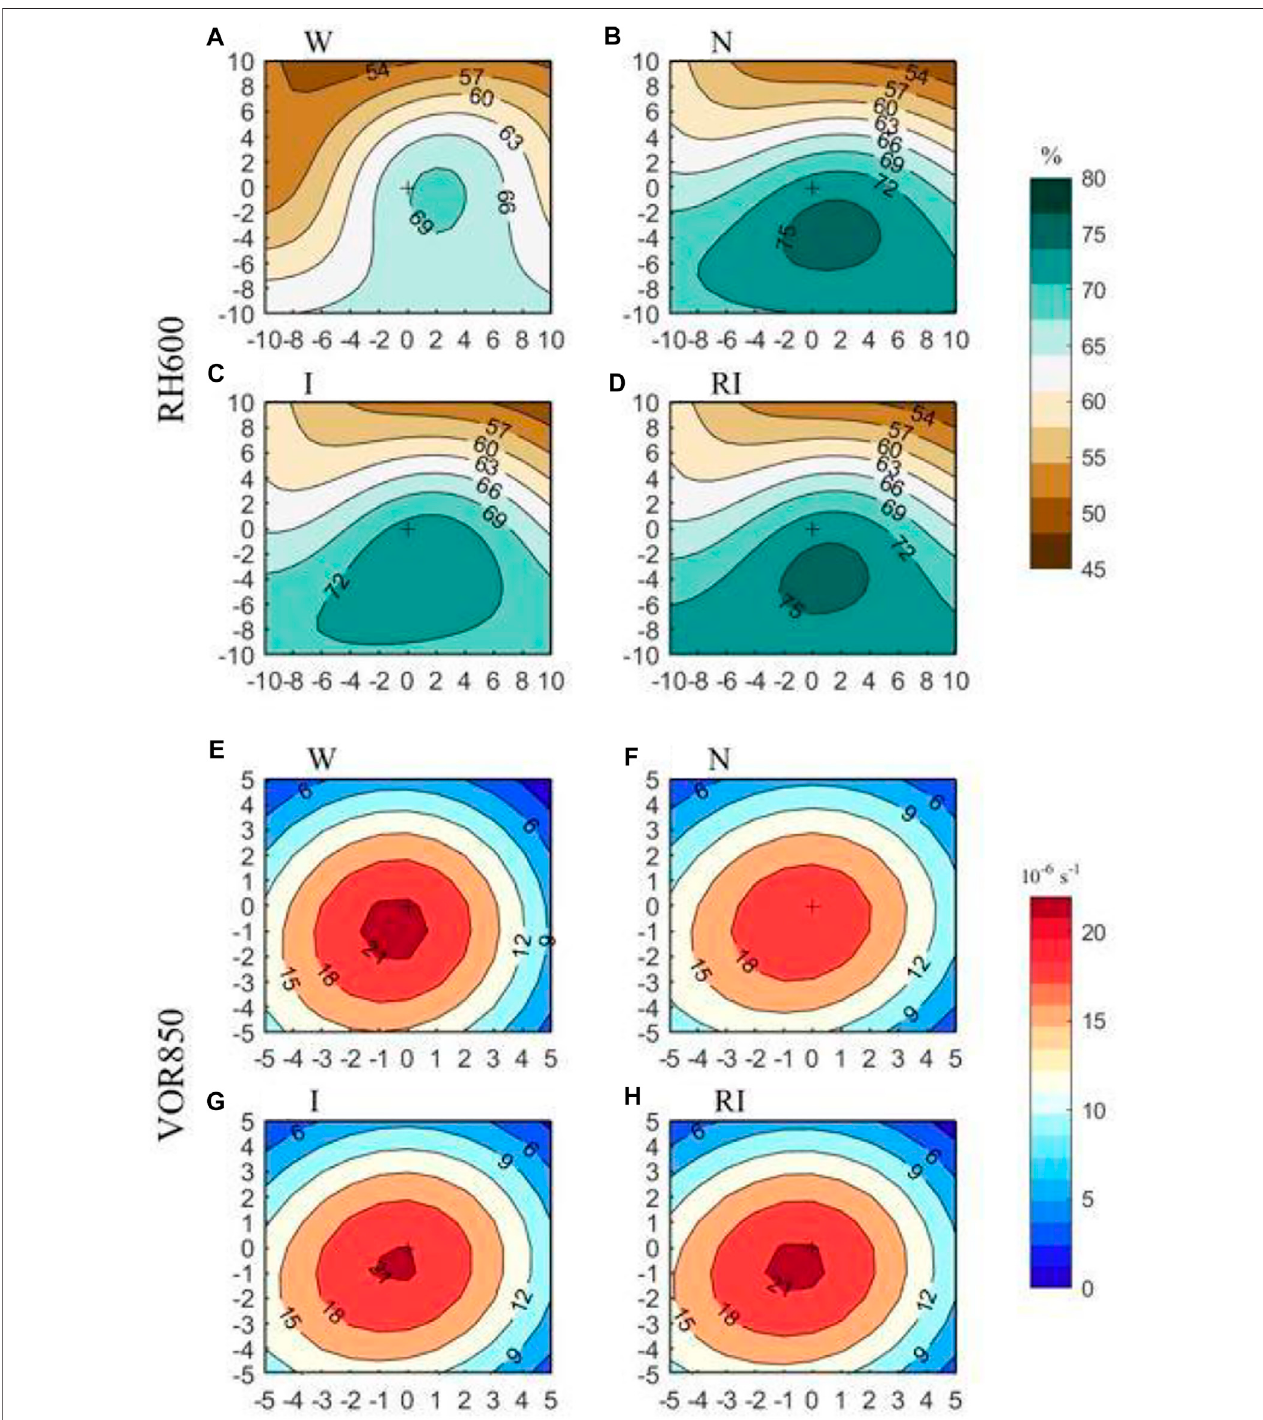
FIGURE 7 | The composites of (A – D) 600-hPa relative humidity (RH600, %) and (E – H) 850-hPa relative vorticity (VOR850, 10 – 6 s − 1 ) for four intensity change categories over the MSC described in Table 3 . In each category, the top-left panel is the weakening (W) composite, the top-right panel is the neutral (N) composite, the bottom-left panel is the intensifying (I) composite, and the bottom-right panel is the rapidly intensifying (RI) composite. “ + ” represents the TC center, and the horizontal and vertical coordinates are the latitude and longitude ( ° ) to the TC center.